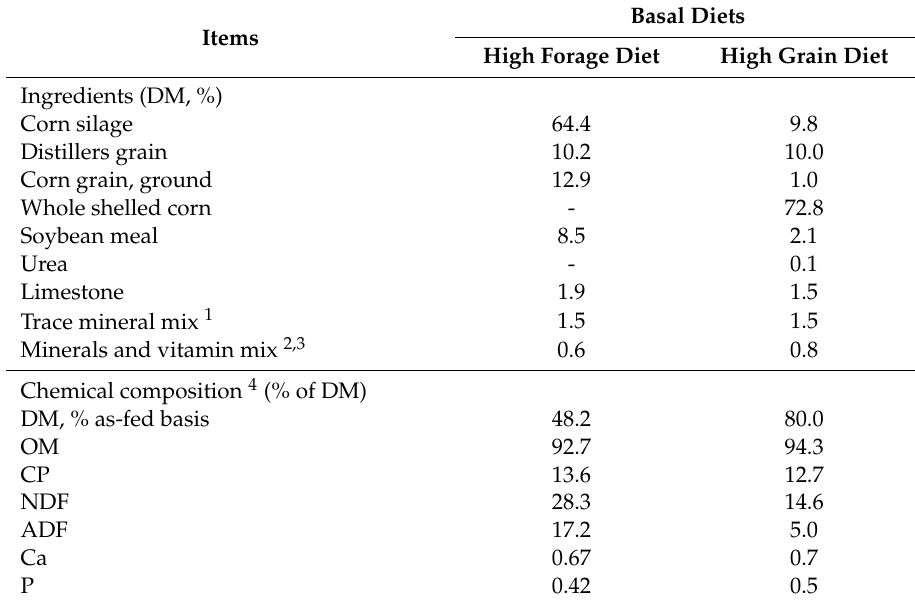
Table 1. Ingredients and chemical composition of the high forage and grain